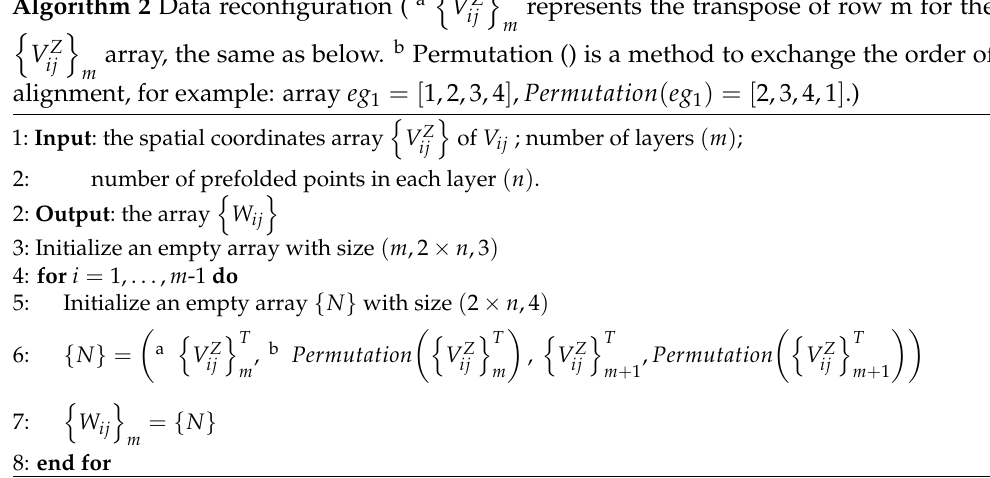
Algorithm 2 Data reconfiguration ( a